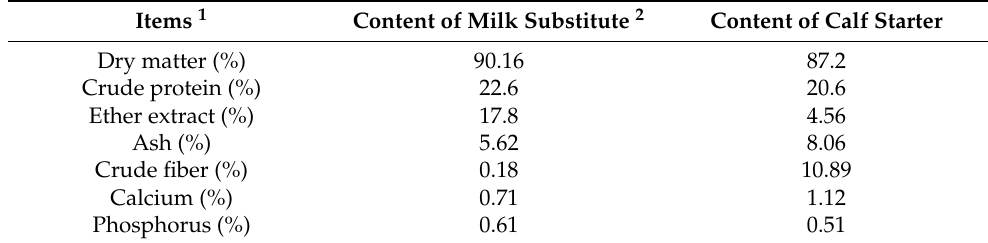
Table 1. Nutrient levels of the milk substitute and calf starter after air-drying. Items 1 Content of Milk Substitute 2 Content of Calf Starter Dry matter (%) 90.16 87.2 Crude protein (%) 22.6 20.6 Ether extract (%) 17.8 4.56 Ash (%) 5.62 8.06 Crude fiber (%) 0.18 10.89 Calcium (%)